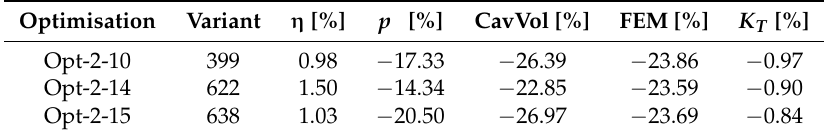
Table 7. Optimal solutions of Group 3, relative to performance of manual